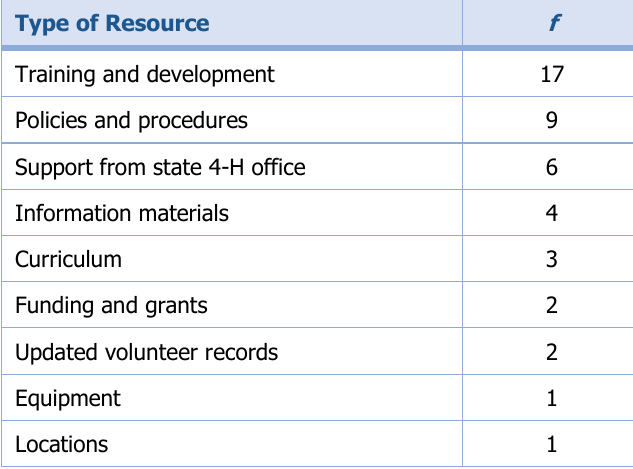
Table 6. Resources Needed to Manage a County 4-H Shooting Sports